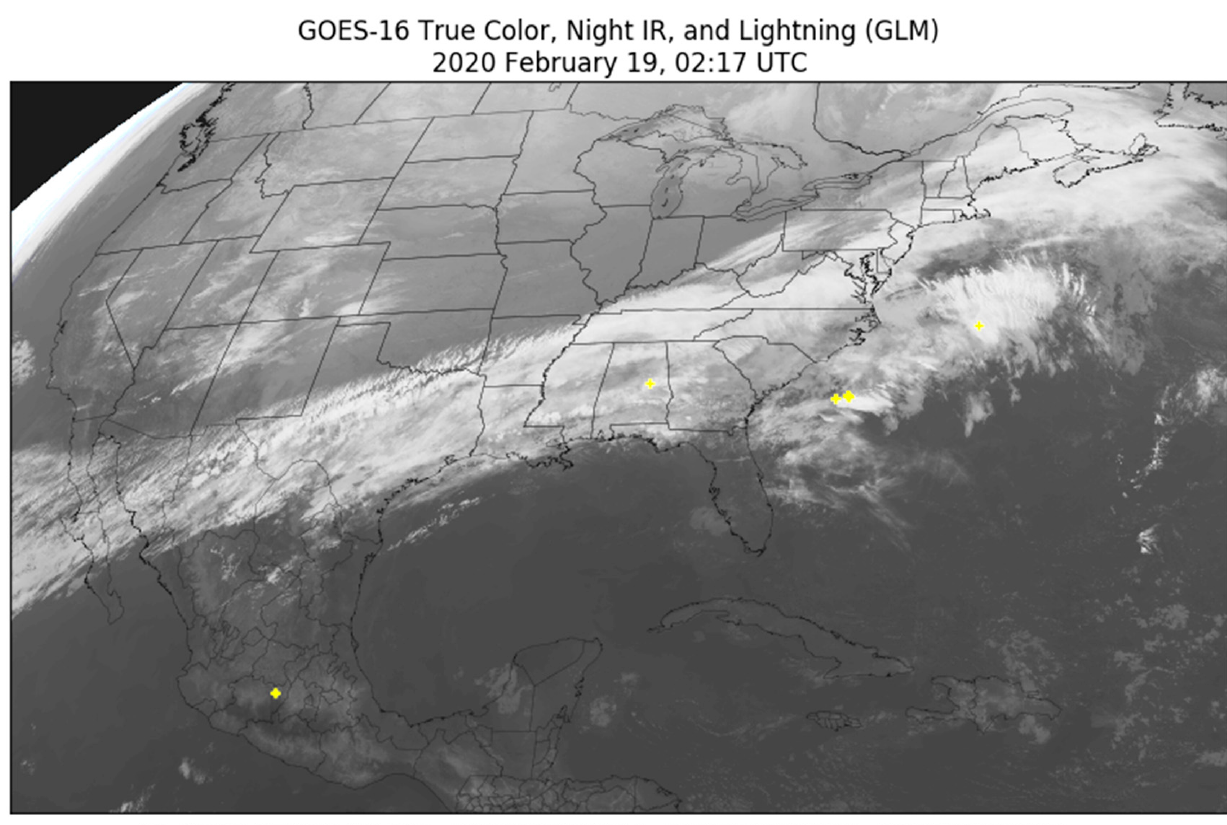
Figure 5. Morelian meteoroid detection by GLM installed on GOES-16.